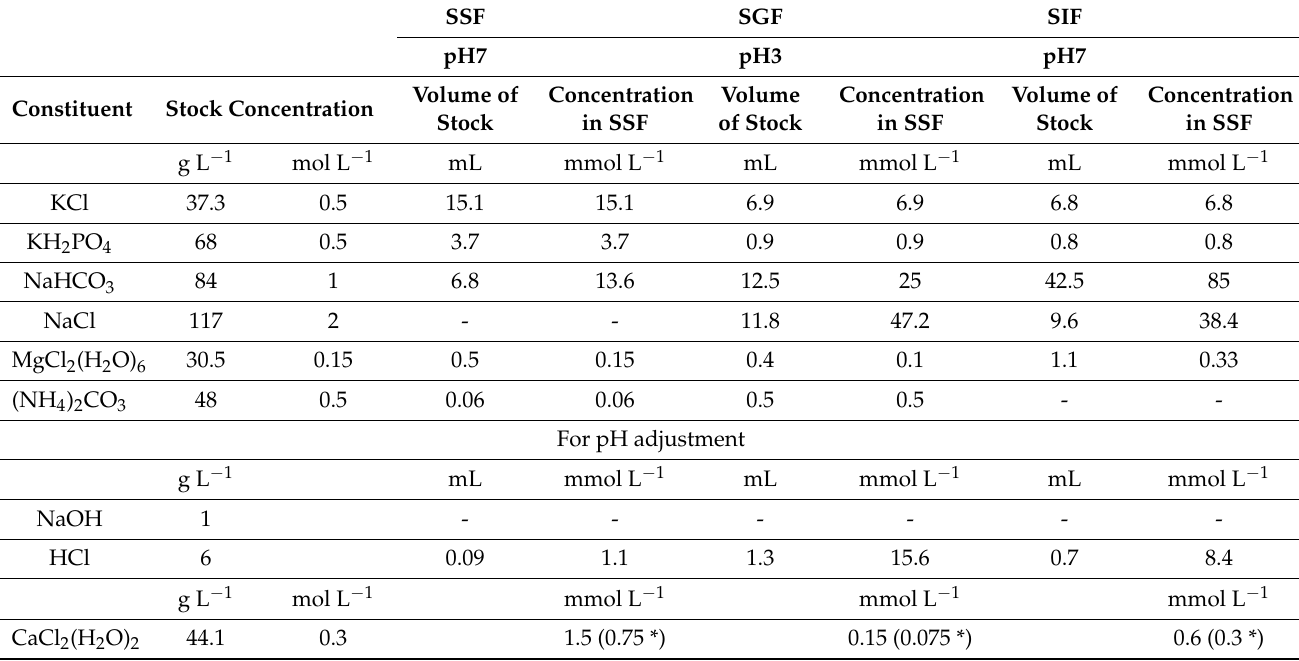
Table 2. Preparation of stock solutions of simulated digestion fluids. Final volume of 500 mL for each